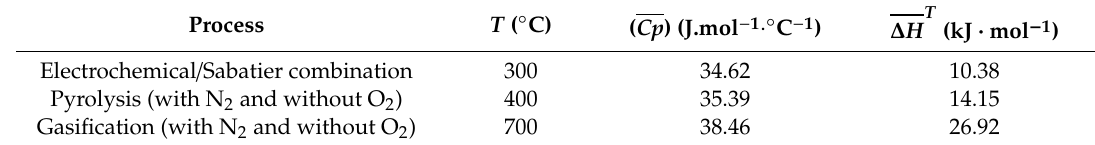
T Table 7. Calculated values of ( Cp ) and ( ∆ H ) for di ff erent syngas / methane production processes. Table 7. Calculated values of ( 𝐶𝑝(cid:3364)(cid:3364)(cid:3364)(cid:3364) ) and (  𝐻(cid:3364)(cid:3364)(cid:3364)(cid:3364) (cid:3021) ) for different syngas/methane production processes. Process Process Electrochemical / Sabatier combination Gasification (with N 2 and without O 2 )